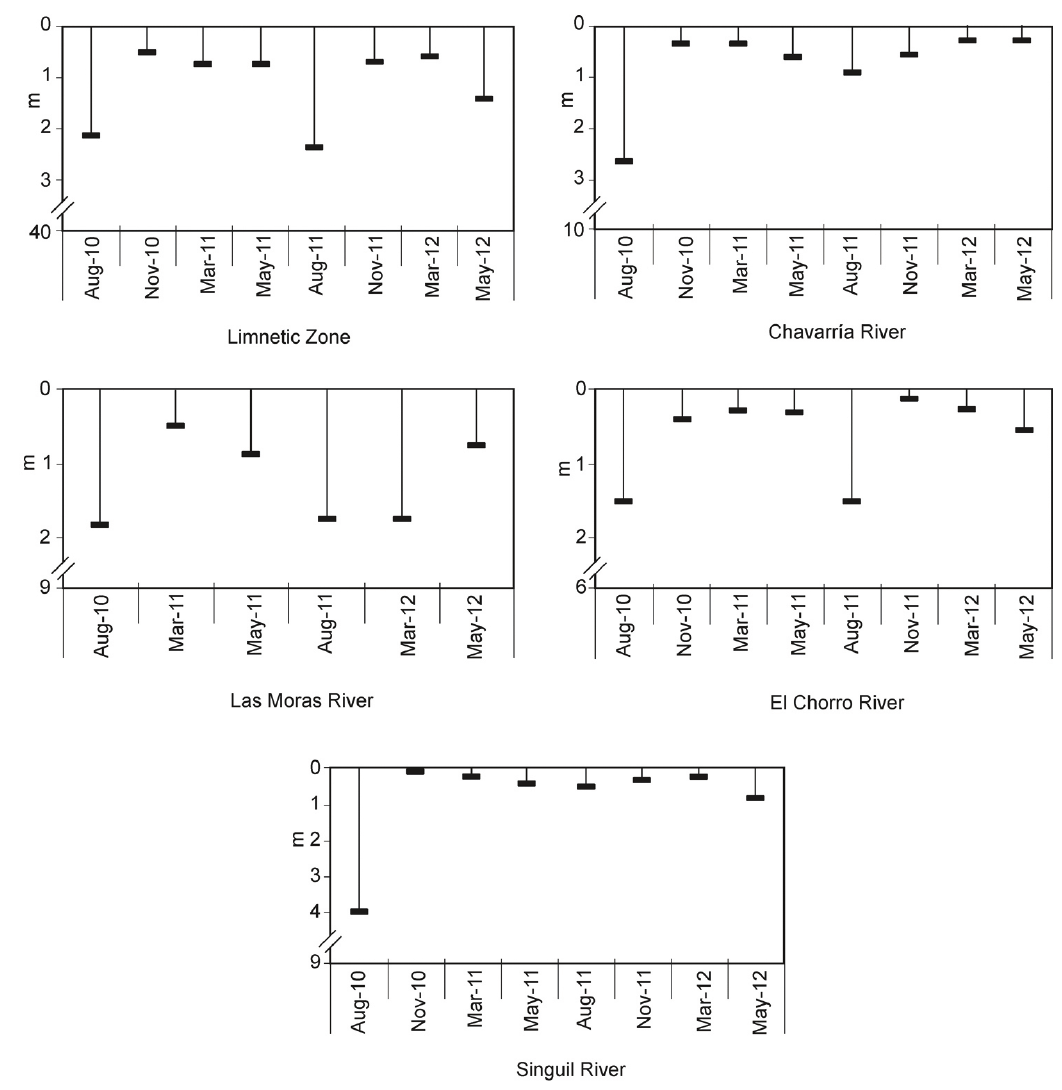
Figure 3. Variation in transparency in the limnetic zone and the mouth of the tributaries.